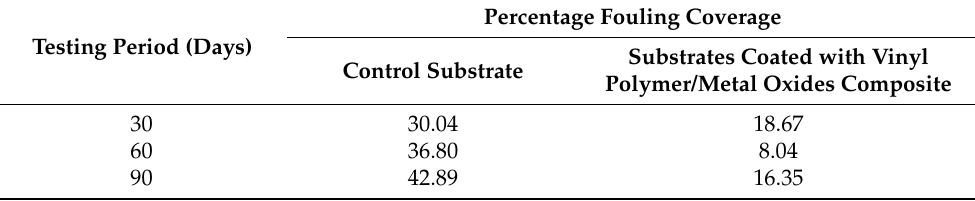
Figure 11. Surfaces of various substrates after: ( a ) immersion in seawater for various times and ( b ) antimicrobial efficacy of the various coatings after immersion in seawater. Table 4. Percentage fouling coverage of the substrates coated with polymer film containing 10% w / v of the composite metal oxides (10%WO 3 @TiO 2